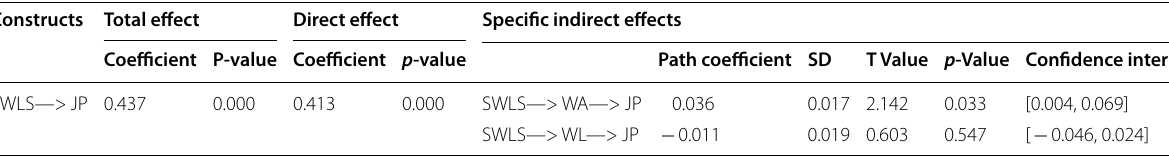
Table 6 Mediation analysis Constructs Total